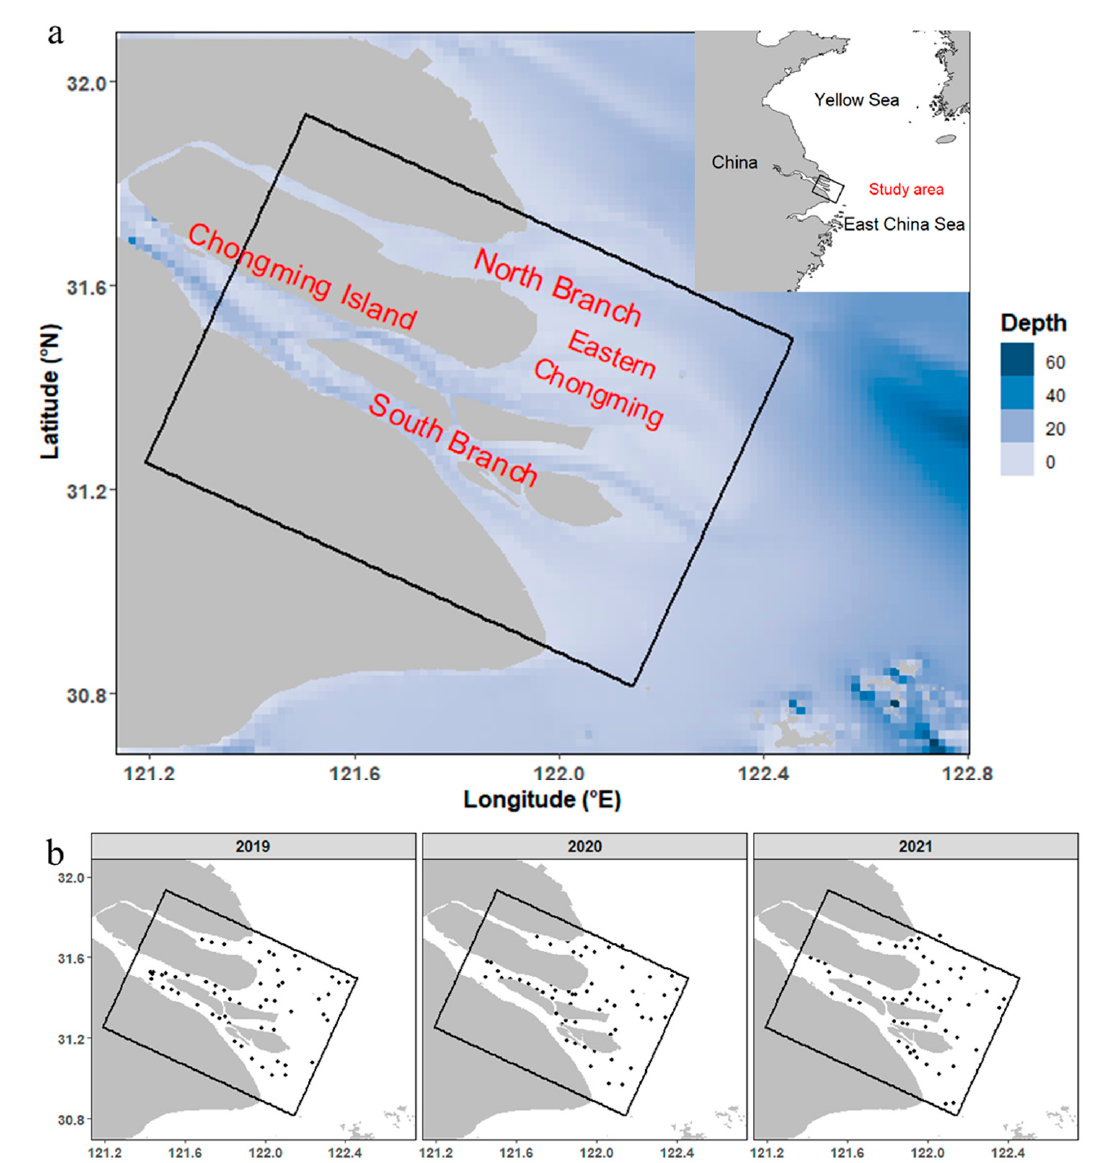
Figure 1. Study area and samples in the Yangtze Estuary ( a ) represents the study area; ( b ) represents the samples. Black boxes represent study area in the present study; points represent sampling stations).